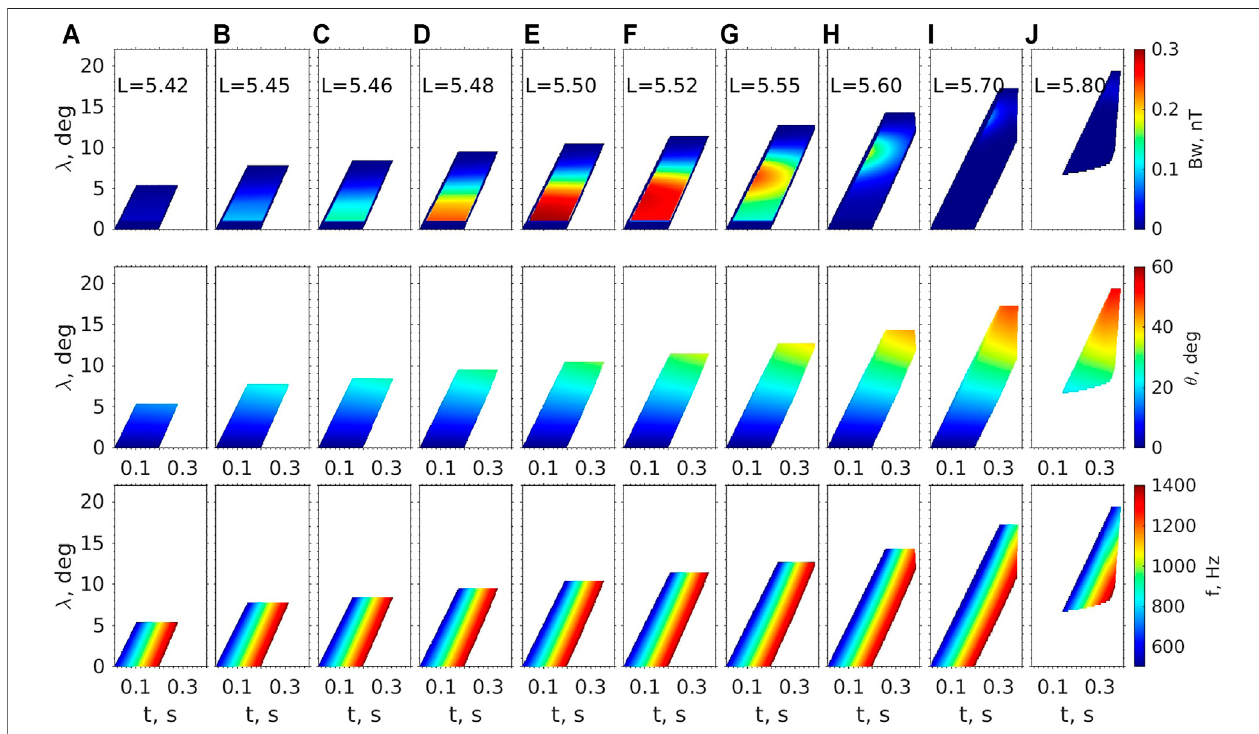
FIGURE 5 | Solution of nonducted chorus elements, wave amplitude B w (top panels) , wave normal angles (middle panels) , and wave frequency (bottom panels) as a function of t and λ , along selected fi eld lines with L values from 5.42 to 5.80 (A – J) .